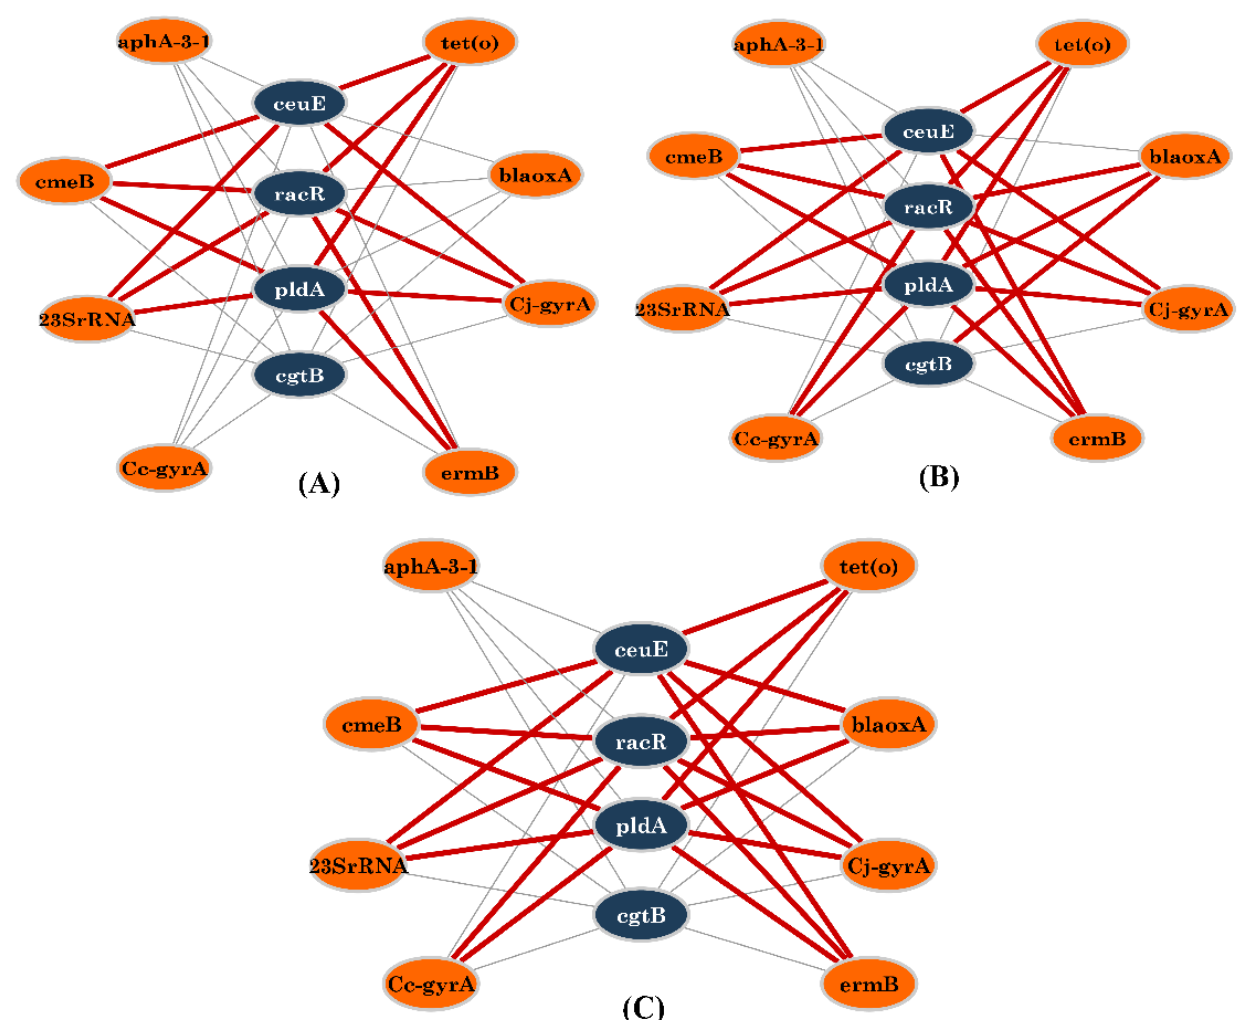
Figure 4. Visualization of the co-occurrence patterns of AR genes and virulence genes across Campylobacter isolates (only virulence genes that showed a statistically significant association were used). Red lines designate a high incidence of connections occurring together between resistance genes and virulence among isolates. The line thickness between the nodes reveals the frequency of isolates with identical coincident connections. The nodes in orange and blue are the resistance genes and the virulence genes, respectively. ( A ) Connections across 50 Campylobacter isolates out of 177 isolates. ( B ) Connections across 100 Campylobacter isolates out of 177 isolates. ( C ) Connections across all Campylobacter isolates ( n = 177). High-frequency connections are shown in red bold lines. AR encoding genes: Quinolones ( gyrA ), erythromycin (23S rRNA), β -lactams ( bla OXA-61 ), tetracycline ( tet (O)), and multidrug-resistance pump (cmeB) .